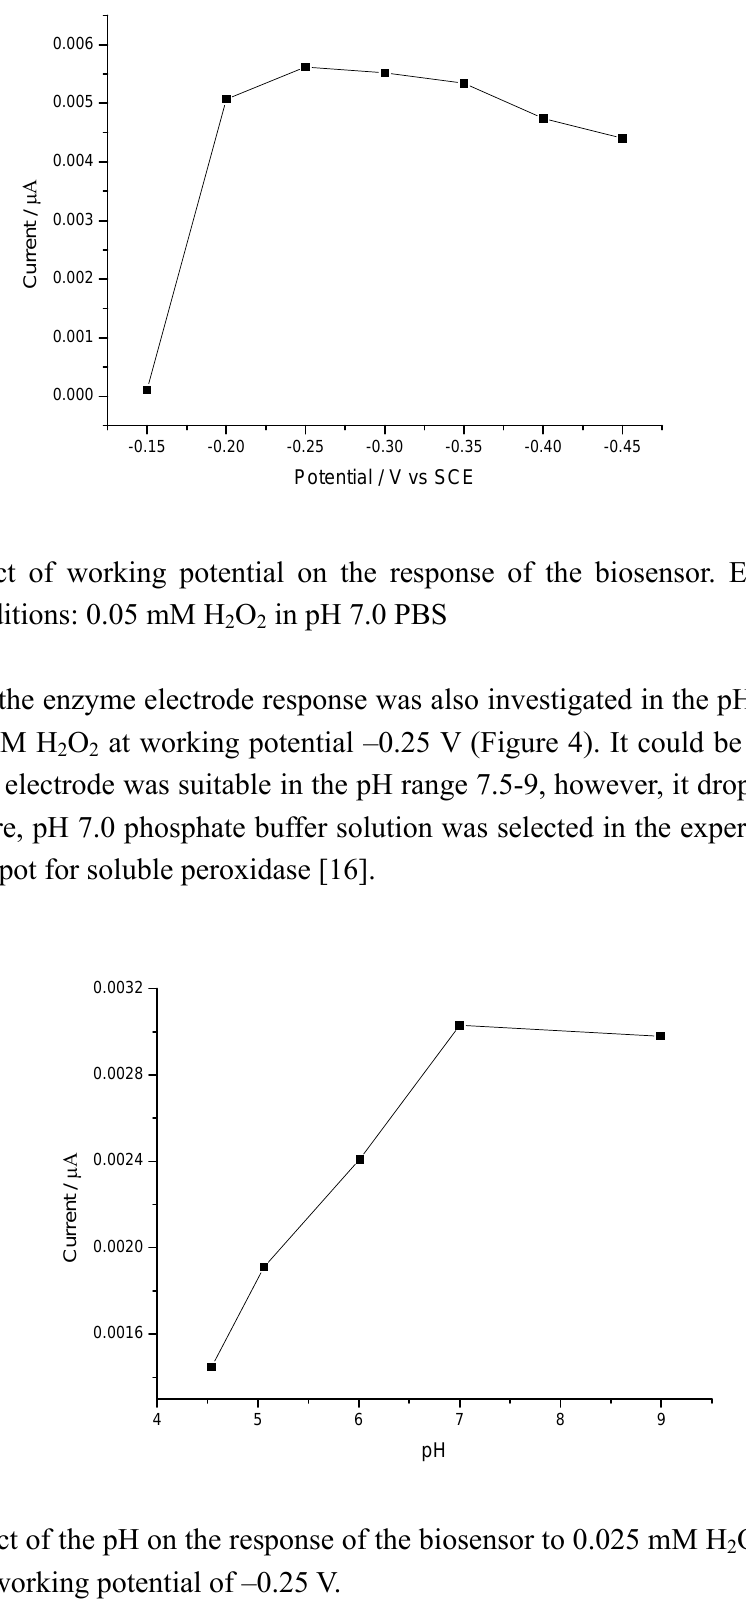
O in PBS at 2 2